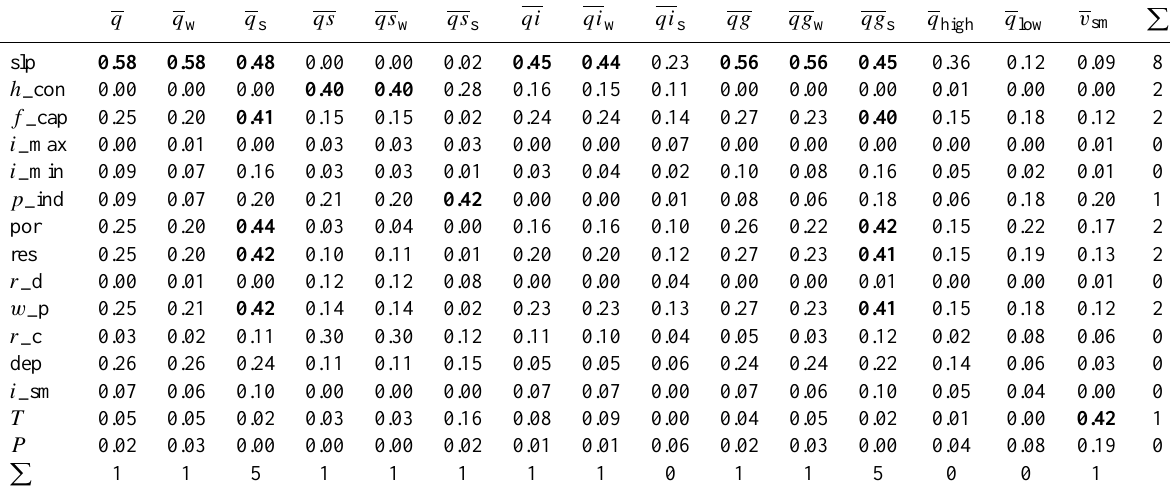
Table 3. ρ 2 values calculated for the WetSpa distributed parameters (rows) and the SCF sensitivity maps under different response functions (columns). ρ 2 (cid:62) 0 . 40 are bold; the frequency that this condition is true is summarized ( P ) in the last row and column. Explanation of the response functions and parameters is presented in Tables 1 and